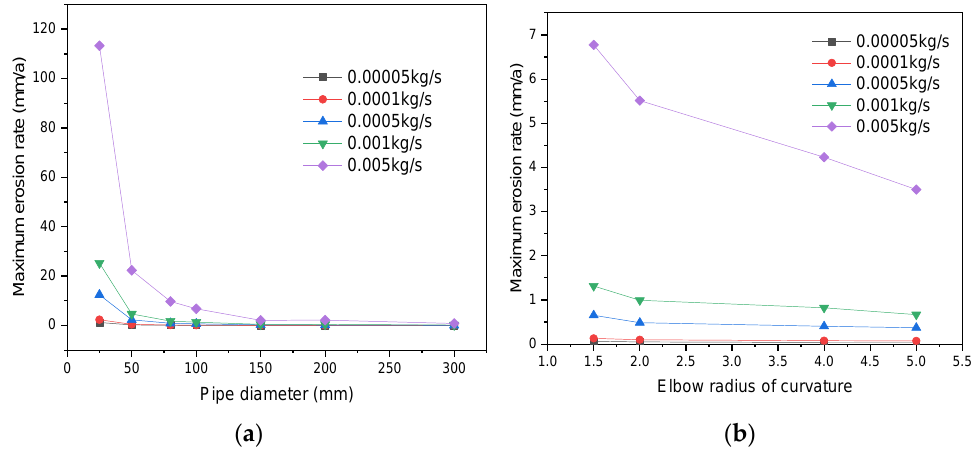
Figure 13. Effect of the pipe diameter and elbow radius of curvature on the maximum erosion rate. ( a ) Pipe diameter; ( b ) Elbow radius of curvature.